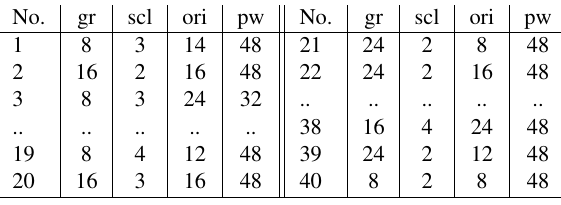
Table 3: Public Viewing dataset: The images with the lowest and highest similarity measures and the used Gabor filter parameters.(No.= Image index which corresponds to the images in Figure 4, gr=Gabor radius, scl=Number of scales, ori=Number of orientations, pw=Patch width)